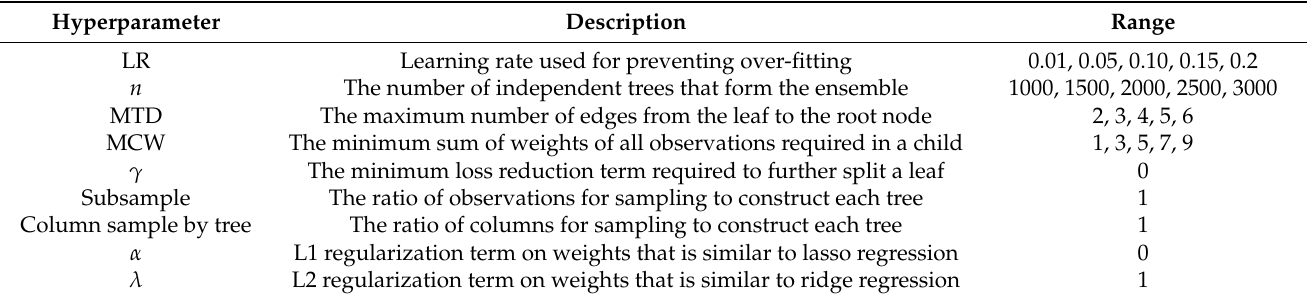
Table 4. Ranges of key hyperparameter values for the XGBoost used in cross-validation.